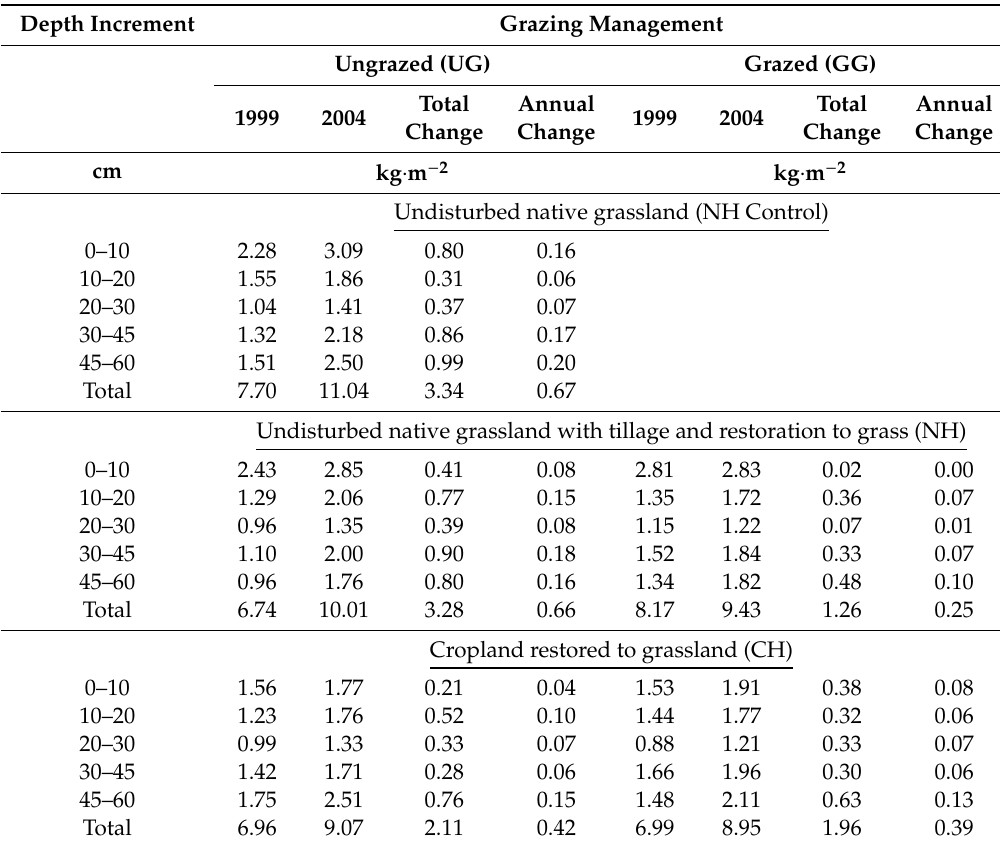
Table 2. E ff ects of management on profile changes in soil organic carbon levels over a five year period for undisturbed native grassland that was tilled and restored to grass and long-term cropland converted to